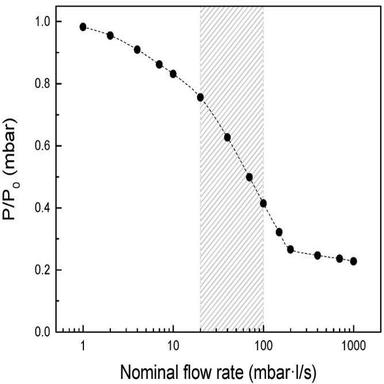
Ratio of the μPG, sensor 10) pressure reading at a given MS gas flow rate, referenced to the pressure reading full flow through the TMP branch (MS valve closed).